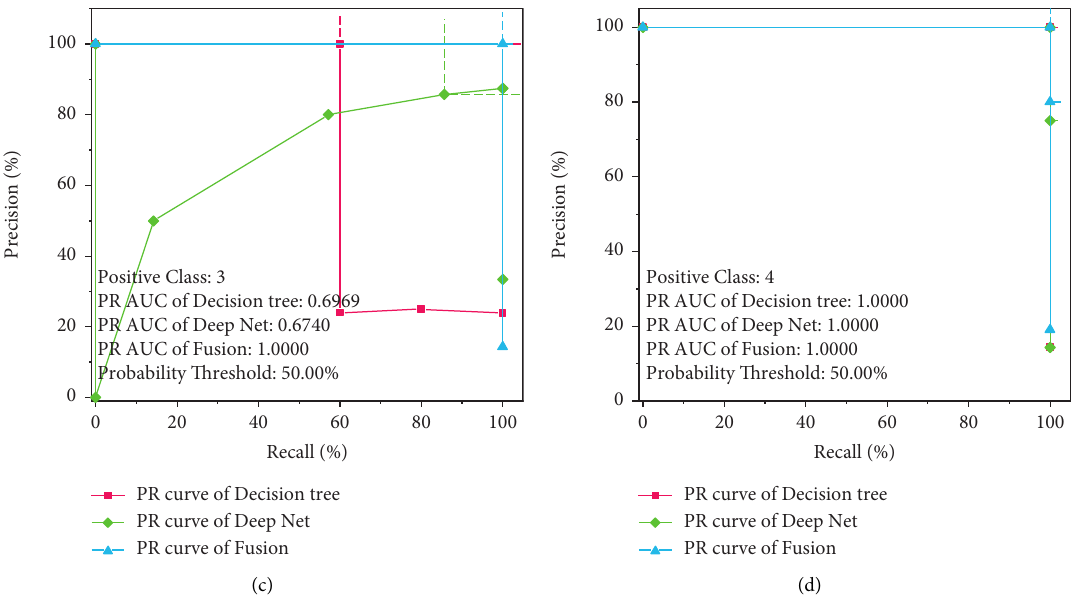
Figure 19: PR curve of each classification test of the fusion model.